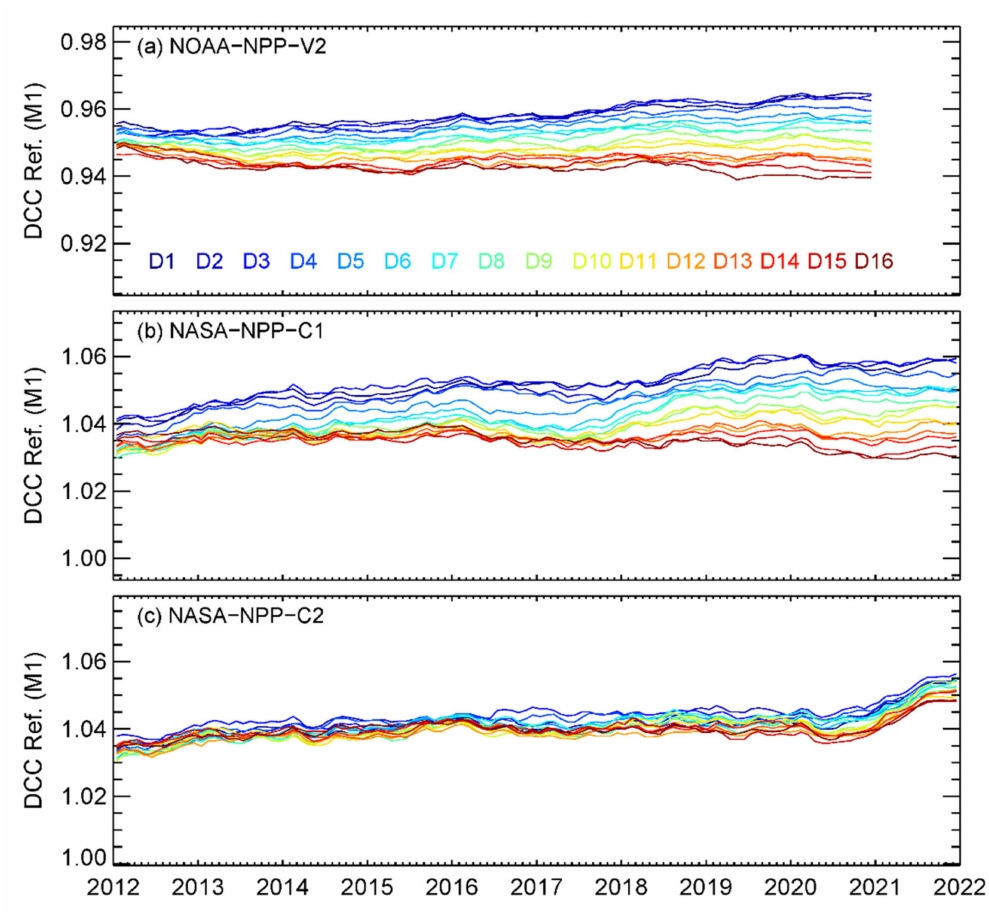
Figure 3. Detector level monthly DCC time series for S-NPP VIIRS